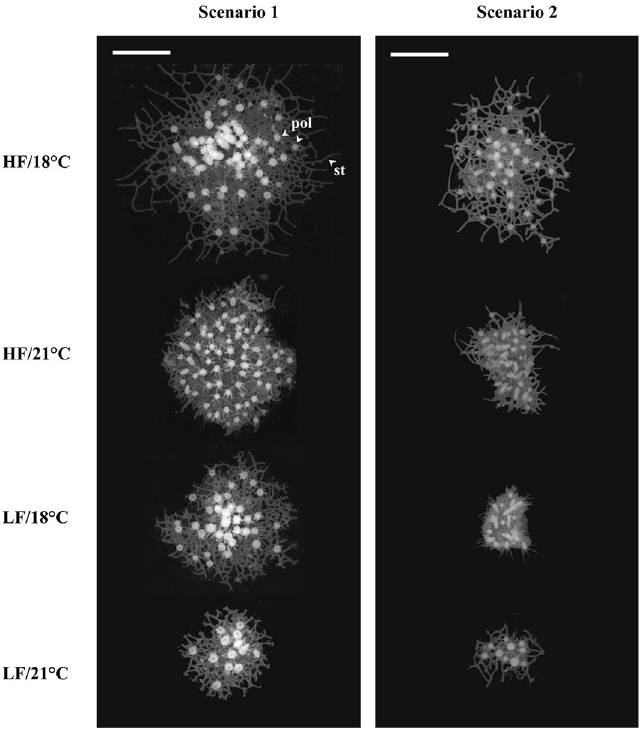
Figure 1. Representative images of juvenile H. echinata colonies in all treatments of scenario 1(left) and 2 (right) by the end of both experiments. HF = high food, LF = low food, 18 °C = control temperature, 21 °C = high temperature, st = stolon channels, pol = polyps. The white scale bar equals 2 mm.